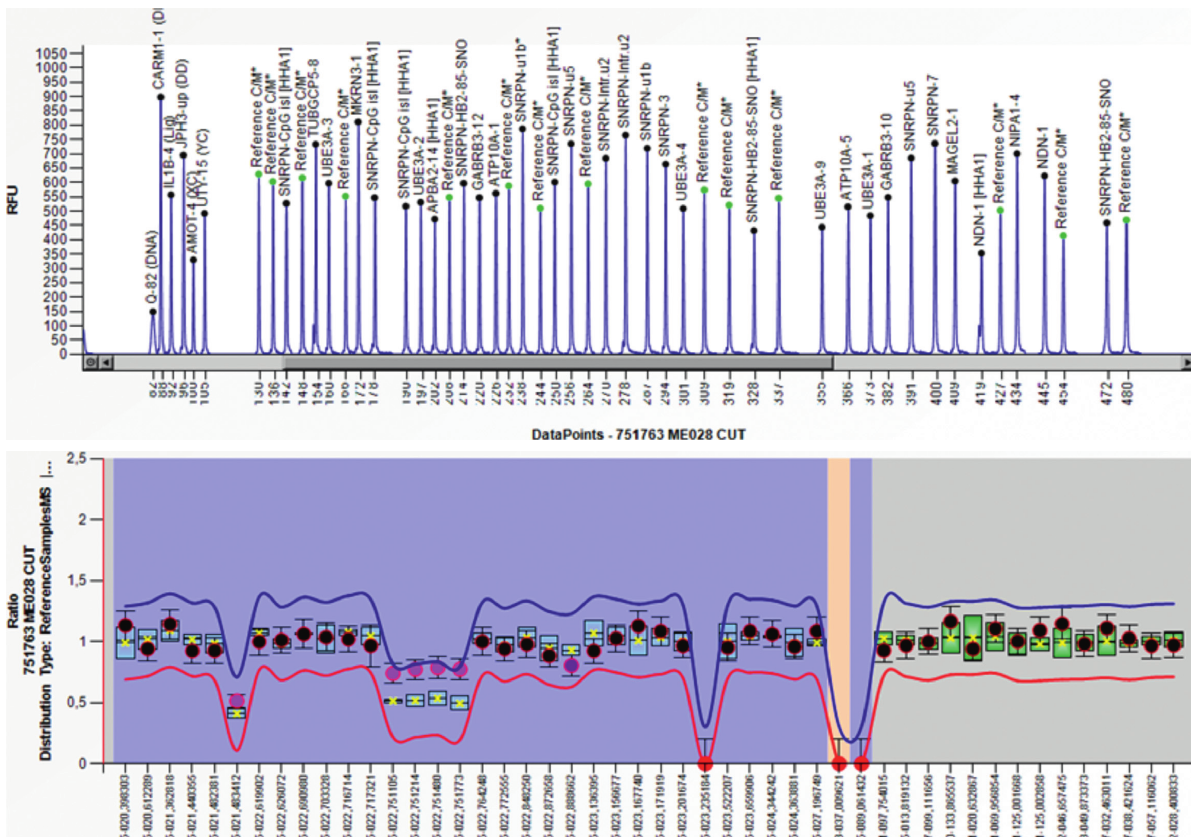
Figure 3: Abnormal methylation pattern in the SNRPN gene due to duplication of region